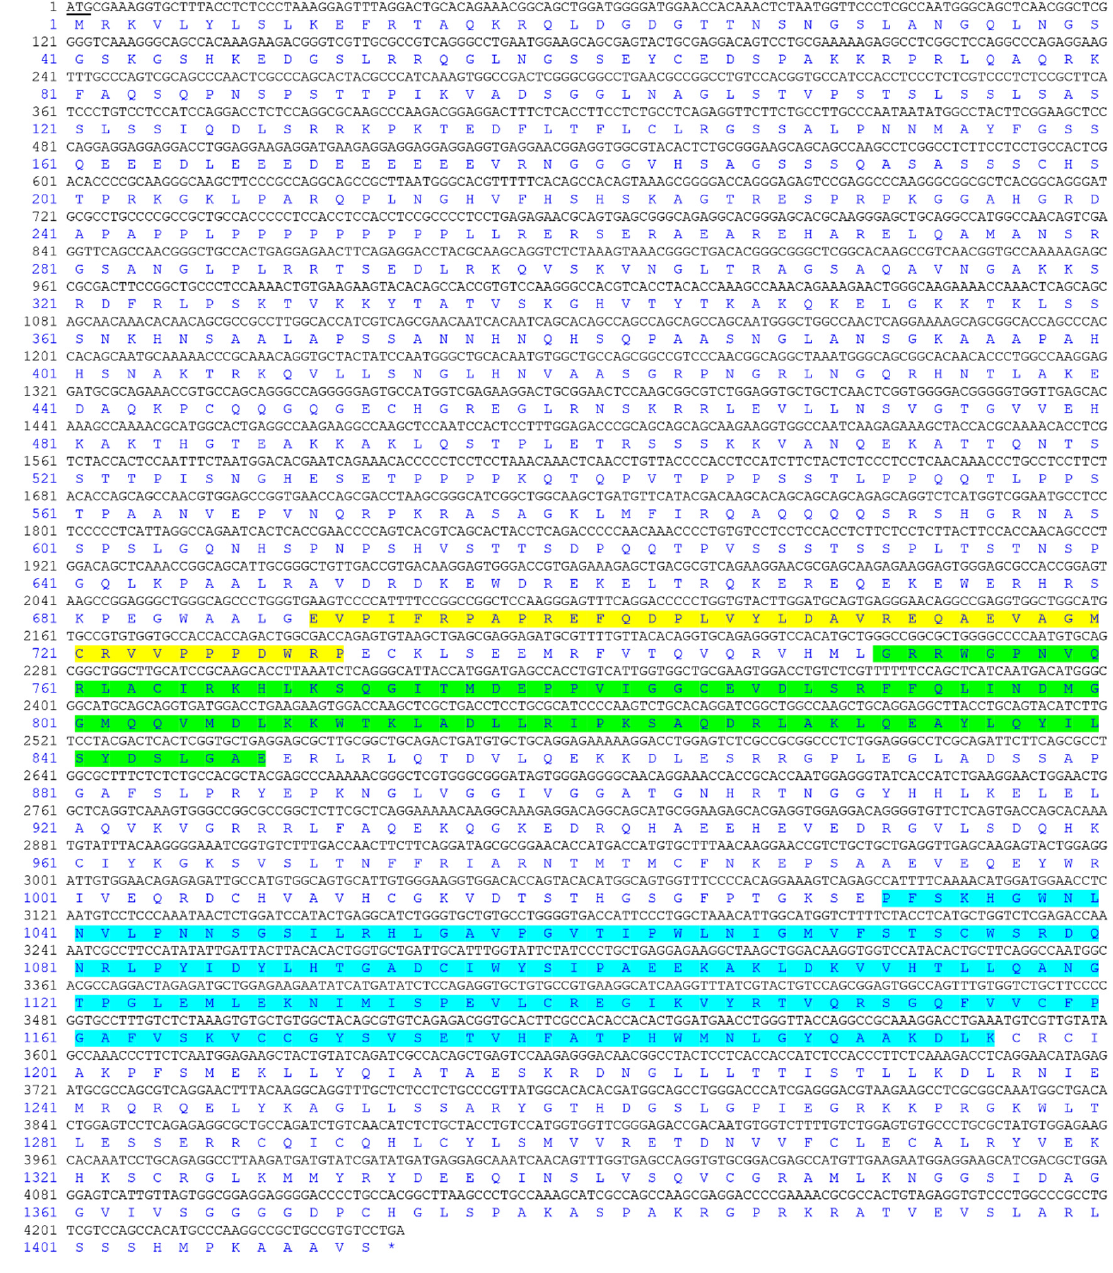
Figure 1. Complete coding sequence and deduced protein sequence of Jarid2b in Nile tilapia (GenBank accession number: ON571717). Positions of nucleotides and amino acids are labeled on the left. The predicted JmjN domain, BRIGHT and ARID domain, and JmjC domain are shaded in yellow, green, and blue-grey, respectively. Underline represents the initiation codon. The stop codon is marked by an asterisk (*).